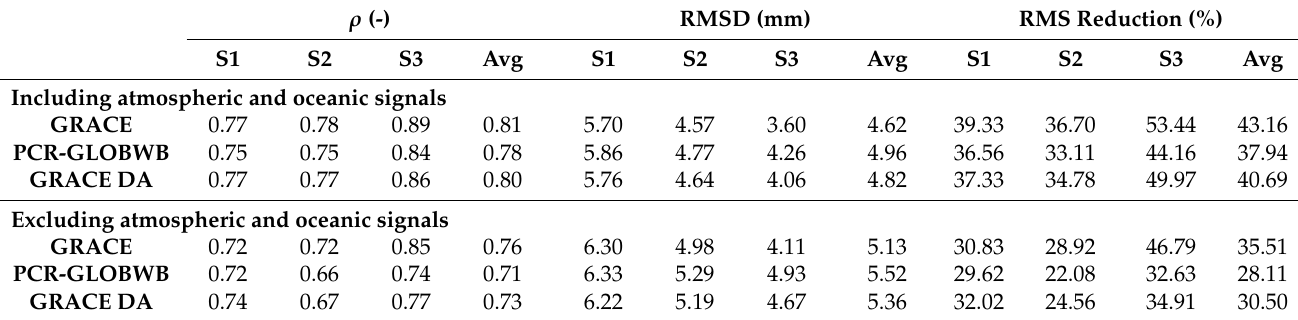
Table 4. The ρ , RMSD, and RMS reduction values (with respect to GPS data) estimated from the GRACE, PCR-GLOBWB, and GRACE DA-derived ∆ r at three evaluated sites (S1–S3). The statistical values associated with the inclusion (top part) and exclusion (bottom part) of atmospheric and oceanic loadings are shown. The average amplitude and phase values are also given in the right column